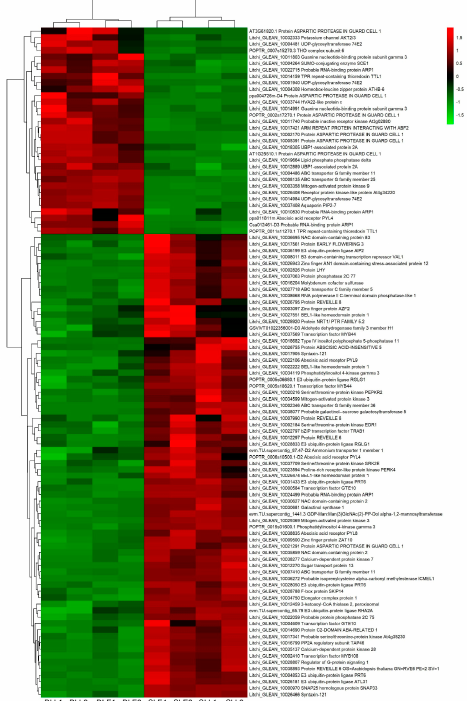
Figure 4. Heat map diagram showing the unique ABA-related differentially expressed genes (DEGs) between senescing and developing panicle leaves at an early stage (upper panel) and those at a later stage (lower panel). Litchi trees were transferred to a growth chamber at 18 °C to induce panicle leaf senescence when panicle primordia emerged. The other trees were transferred to a growth chamber at 26 °C to encourage panicle leaf development. FPKM values of the samples were normalized to Z-score.